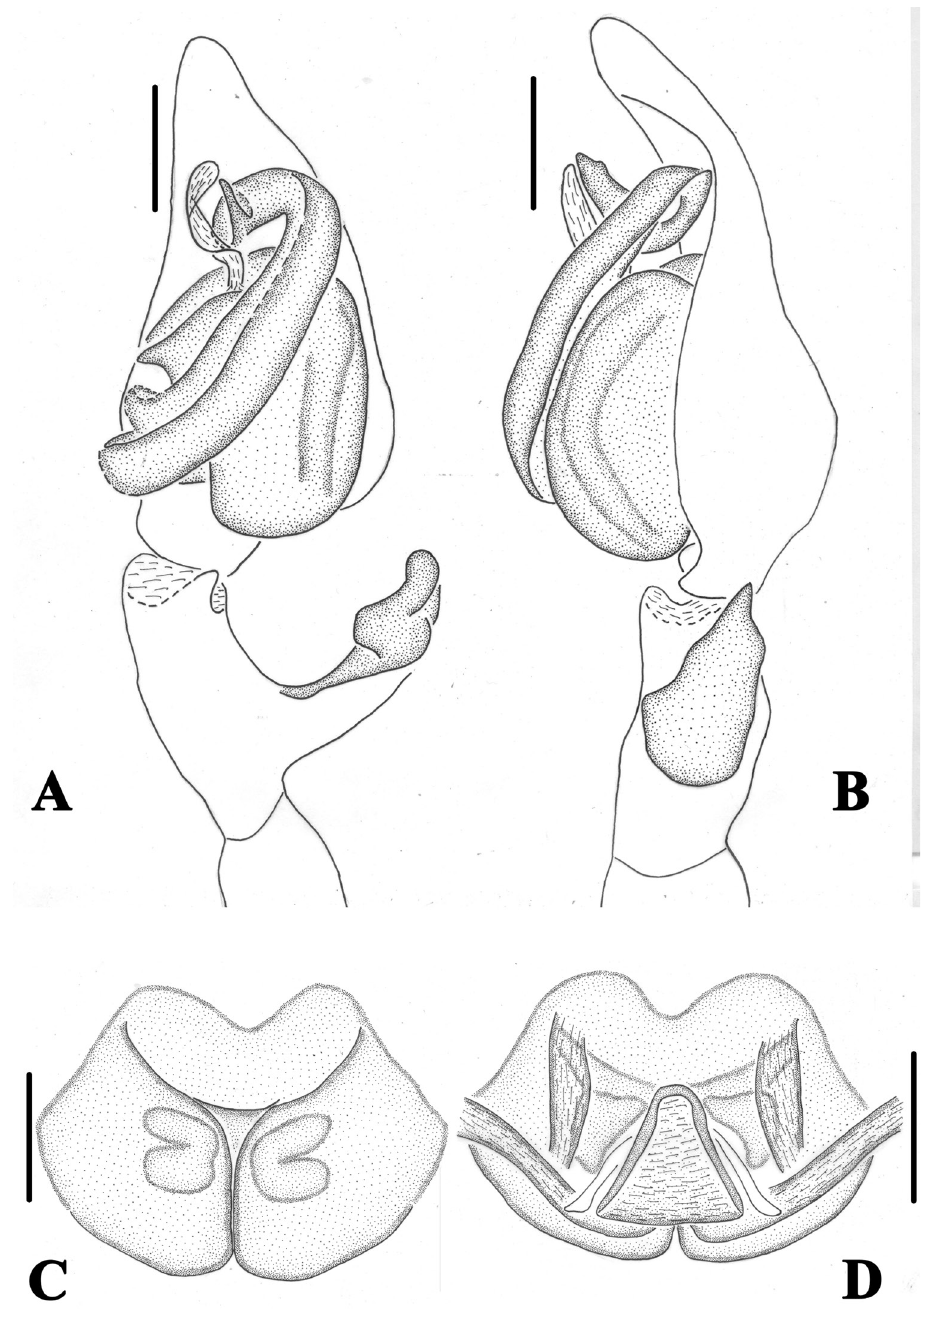
Figure 10. Pseudopoda semilunata sp. nov. A, B left male palp ( A ventral B retrolateral) C epigyne, ventral D vulva, dorsal. Scale bars: